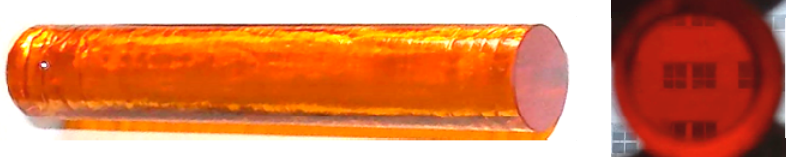
Figure 1. Note that optical inhomogeneities (striae, bubbles, crystallites) in the sample volume are not visually noticeable, do not appear when scanning with a He-Ne laser beam, and even the whole long preform does not distort objects when looking through.